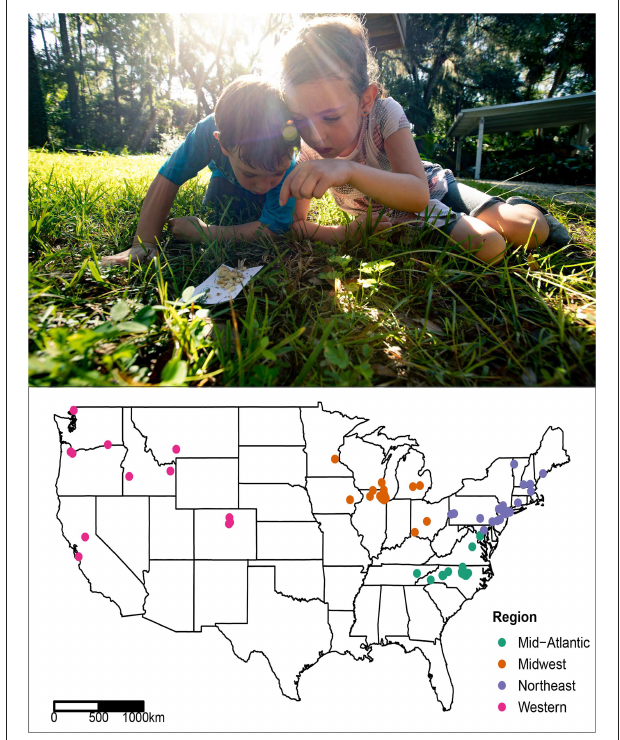
FIGURE 2 | (Top) Pavement ant specimens were collected by public participants, most of them children, through the public science project, the School of Ants (Photo: Jonas Stenstrom). (Bottom) Map of US Tetramorium immigrans specimen sampling localities; colors correspond to geographic